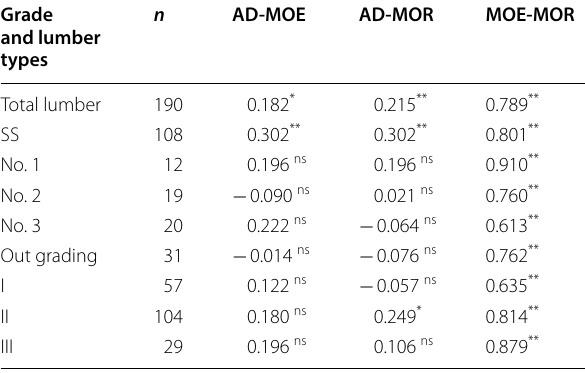
For abbreviations, refer to Tables 2 and 4 ns not